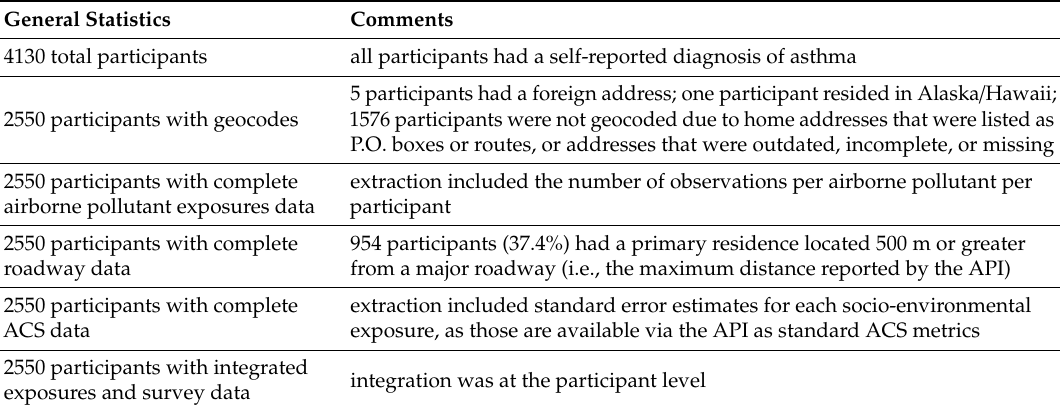
Table 1. EPR data extraction and integration results for the three open Translator Exposures APIs.